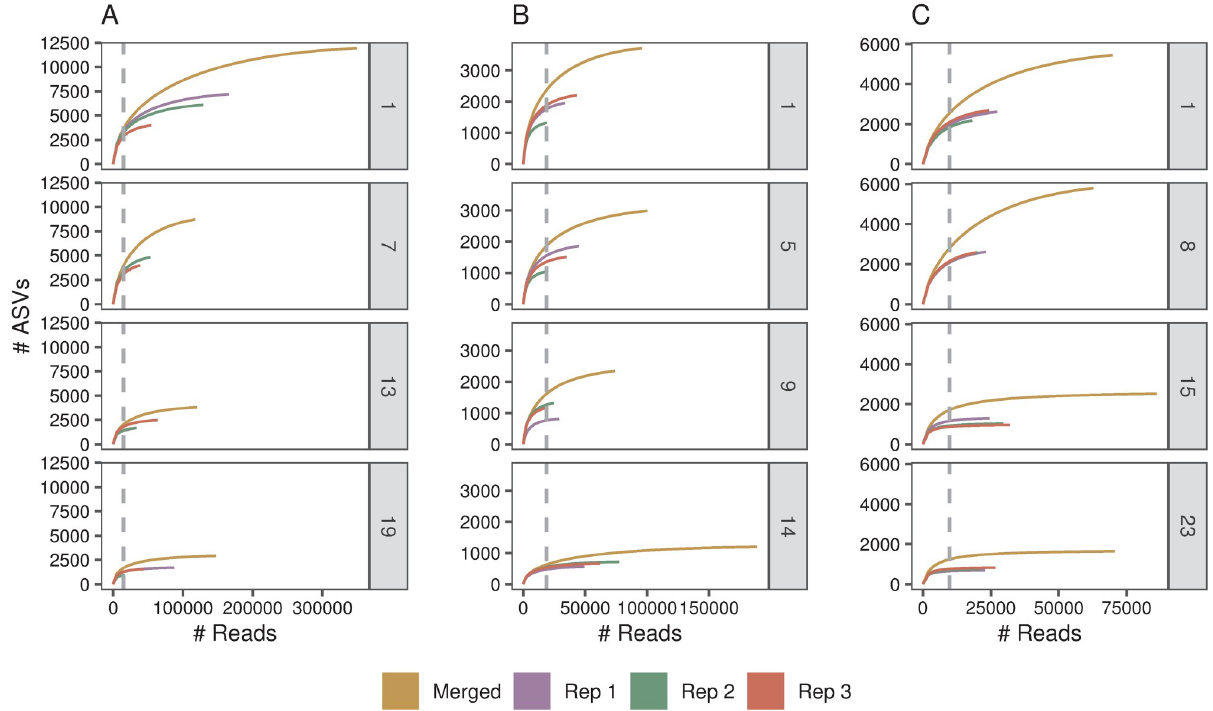
Fig 1. Accumulation curves displaying the observed number of Amplicon Sequence Variants (ASVs) with increasing number of reads for four distinct depth slices (top of core, two slices at intermediate core depths and bottom of core (see S1 Table for depths of slices)) in sediment core samples taken from; A) Lake Nganoke, B) Lake Paringa, and C) Lake Pounui. Accumulation curves are depicted for individual replicates and as a combination of replicates (merged). The level of sub sampling to an even depth used in the further analysis was indicated by the dashed vertical line. Plots for all slices are in S3–S5 Figs. Note: some lines overlap and therefore not all three are visible.